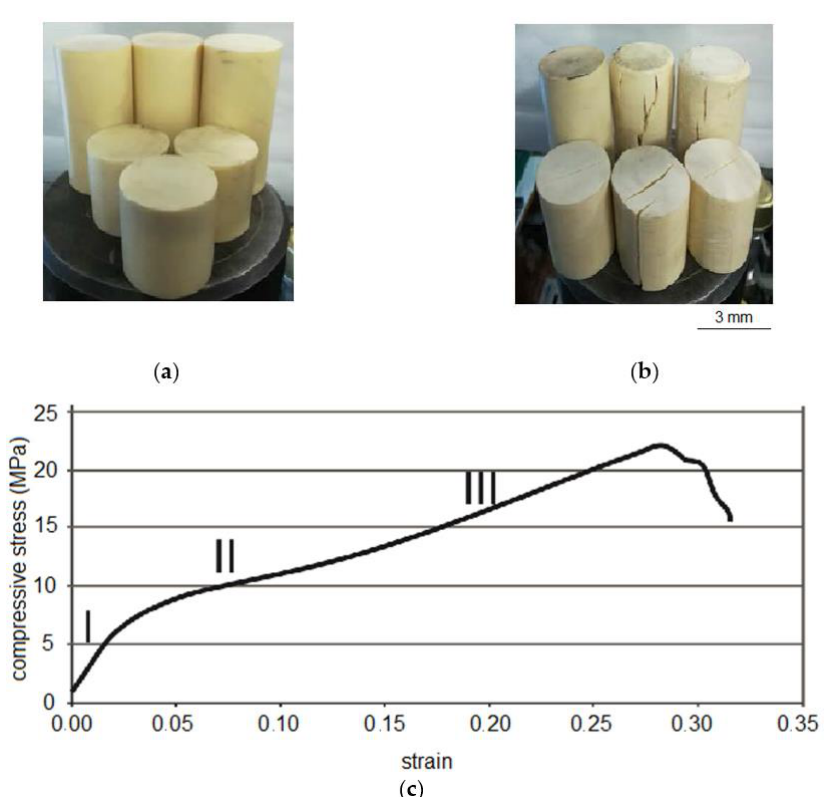
Figure 2. The two-component silicate resin: ( a )—cylindrical specimens of the cured resin; ( b )—the cured resin specimens after uniaxial compression tests with loading rate of 0.5 mm/min; ( c )—stress- strain curve of the cured resin: I—linear section of the curve «stress-strain»; II—section, where stress increases slower; III—section, where stress increases faster until the uniaxial compressive strength of the